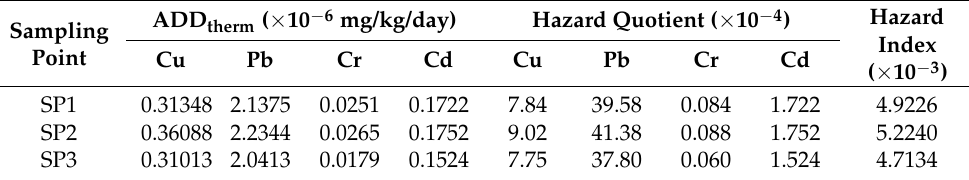
Table 4. Average daily dose, hazard quotient and indices through dermal adsorption of HMs from dredging works in sediments from Port Bell, L. Victoria, Uganda.